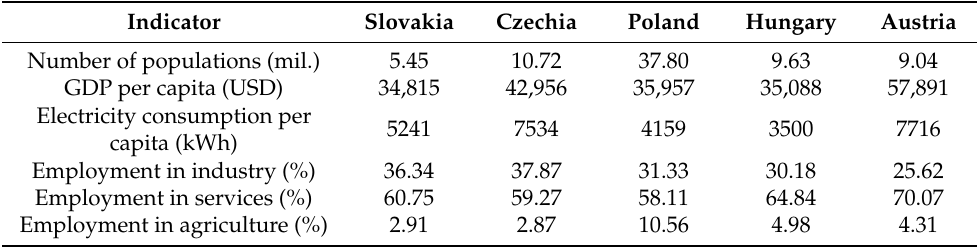
Table 2. Essential economic and energy indicators of compared countries